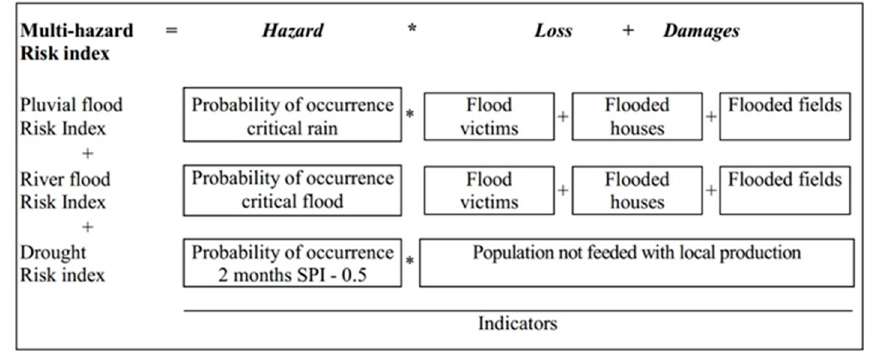
Figure 3. Risk determinants and indicators.